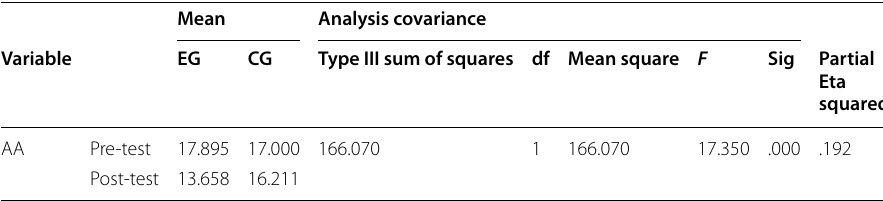
Table 4 Results of ANCOVA for